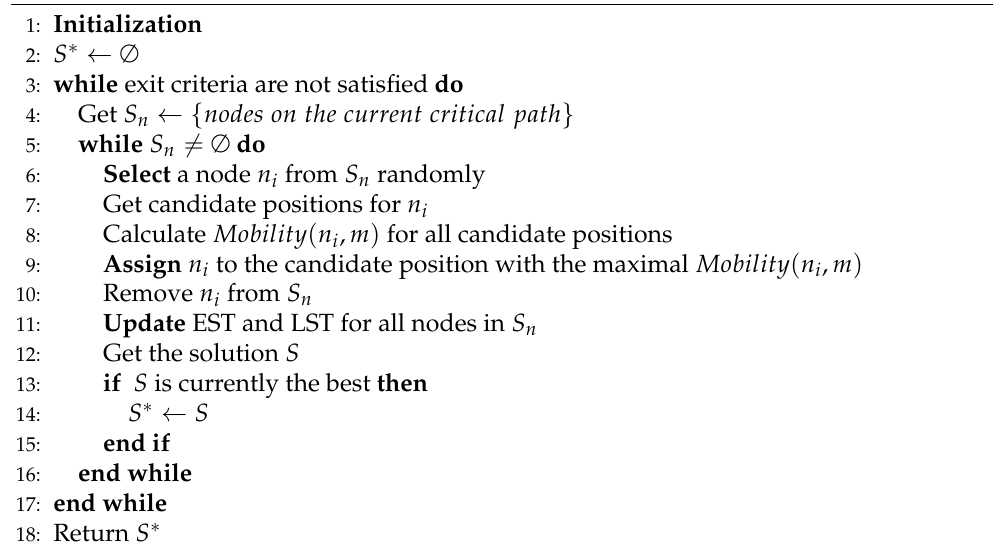
Algorithm 1 The IDCP